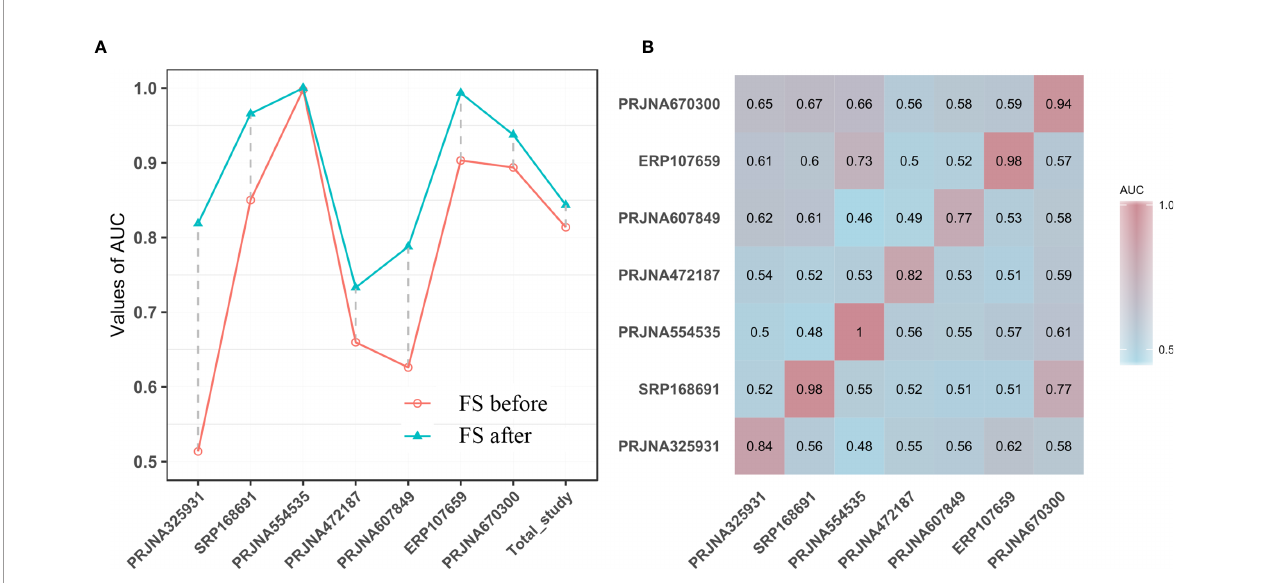
FIGURE 3 | (A) The performances of models to classify the case and the normal before and after feature selection (FS) based on common OTUs; The horizontal ordinates represent the seven studies and the total study. The vertical coordinates depict the AUC of the individual study. (B) T2DM classi fi cation accuracy resulting from cross-validation within each study (the boxed along the diagonal) and study-to-study model transfer (external validations off the diagonal) as measured by the AUROC for the classi fi cation models trained on OTUs. The color of the scale bar on the right represents the AUC